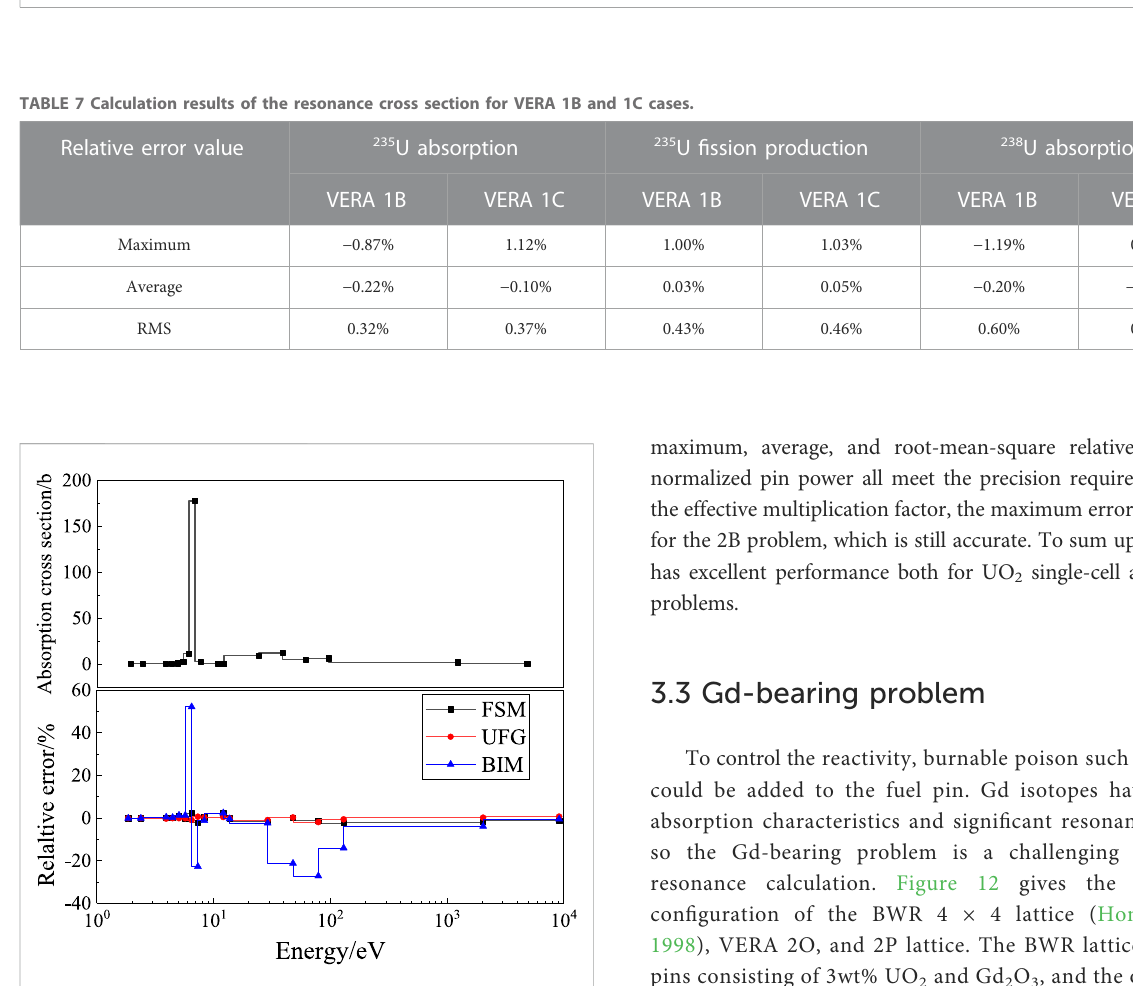
FIGURE 8 Relative deviation ofthe absorption cross-sectionfor 238 U for the 75 wt%